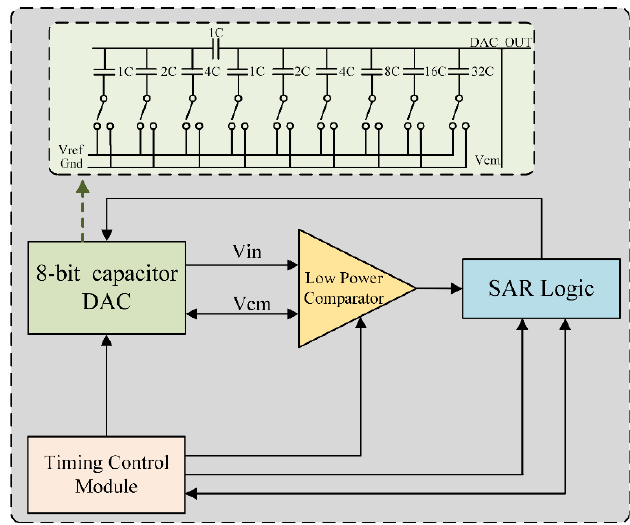
Figure 5. Block diagram of an 8-bit SAR ADC.